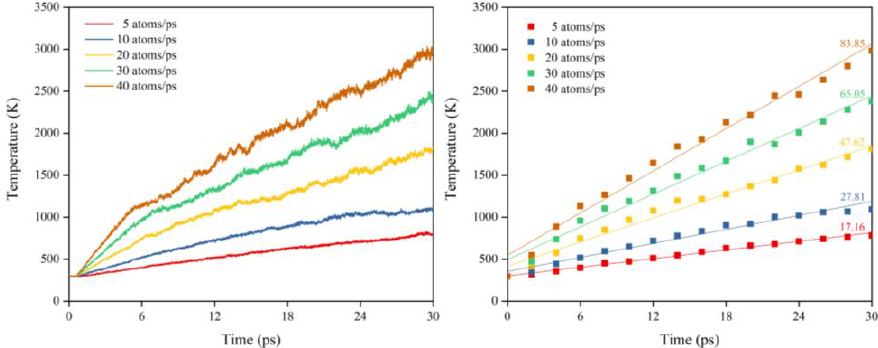
Figure 31. Temperature variation of the Kapton under atomic oxygen impact with different dose rates.